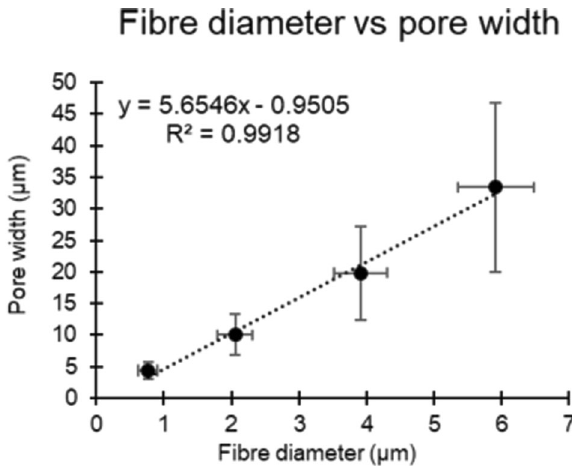
Fig. 2 Correlation between fi bre diameter and pore